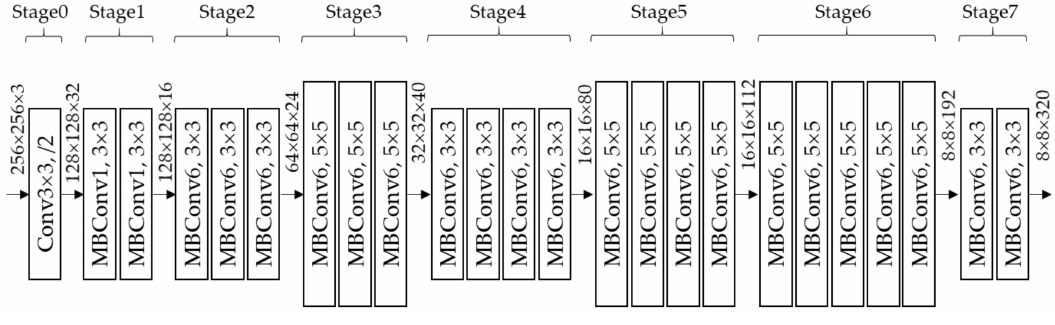
Figure 2. Structure of E ffi cientNet-B1.